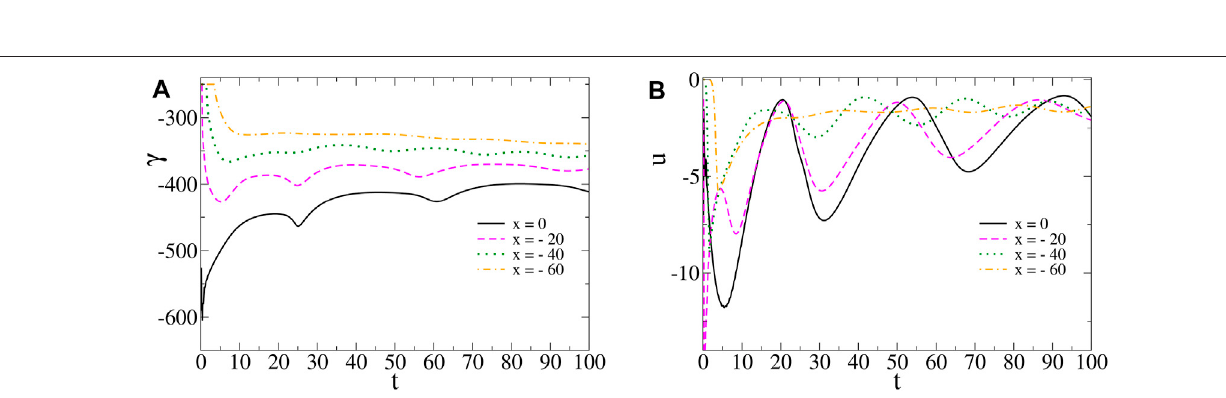
FIGURE5|(A) Surfacetension γ ( x , t )and (B) horizontalcomponentofthe fl uidvelocity fi eld u ( x , z , t )with z =0.90 L z ,asafunctionoftimeatvariousspatiallocations and for the same parameters values as in Figure 2 . Aperiodic temporal oscillations emerge and dampen in the course of time with reducing amplitudes as we consider spatial locations further away from the